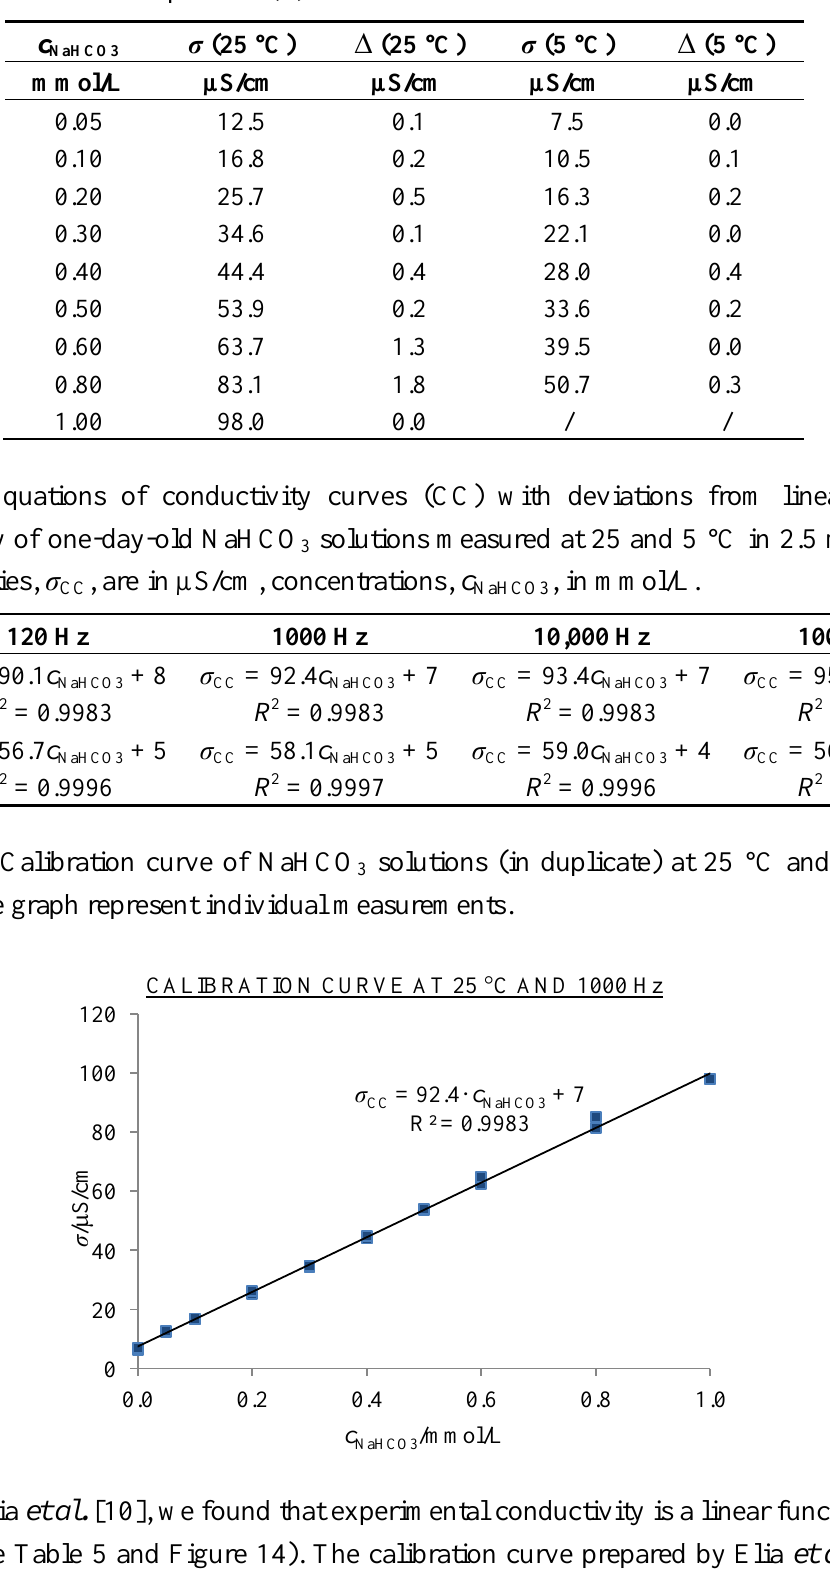
solutions (in duplicate) with 3